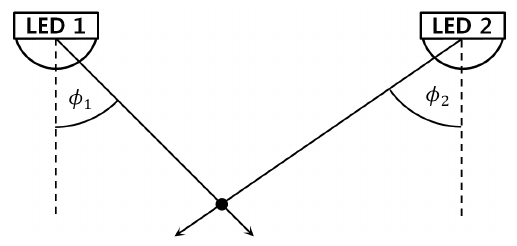
Figure 9. Positioning based on angle of arrival